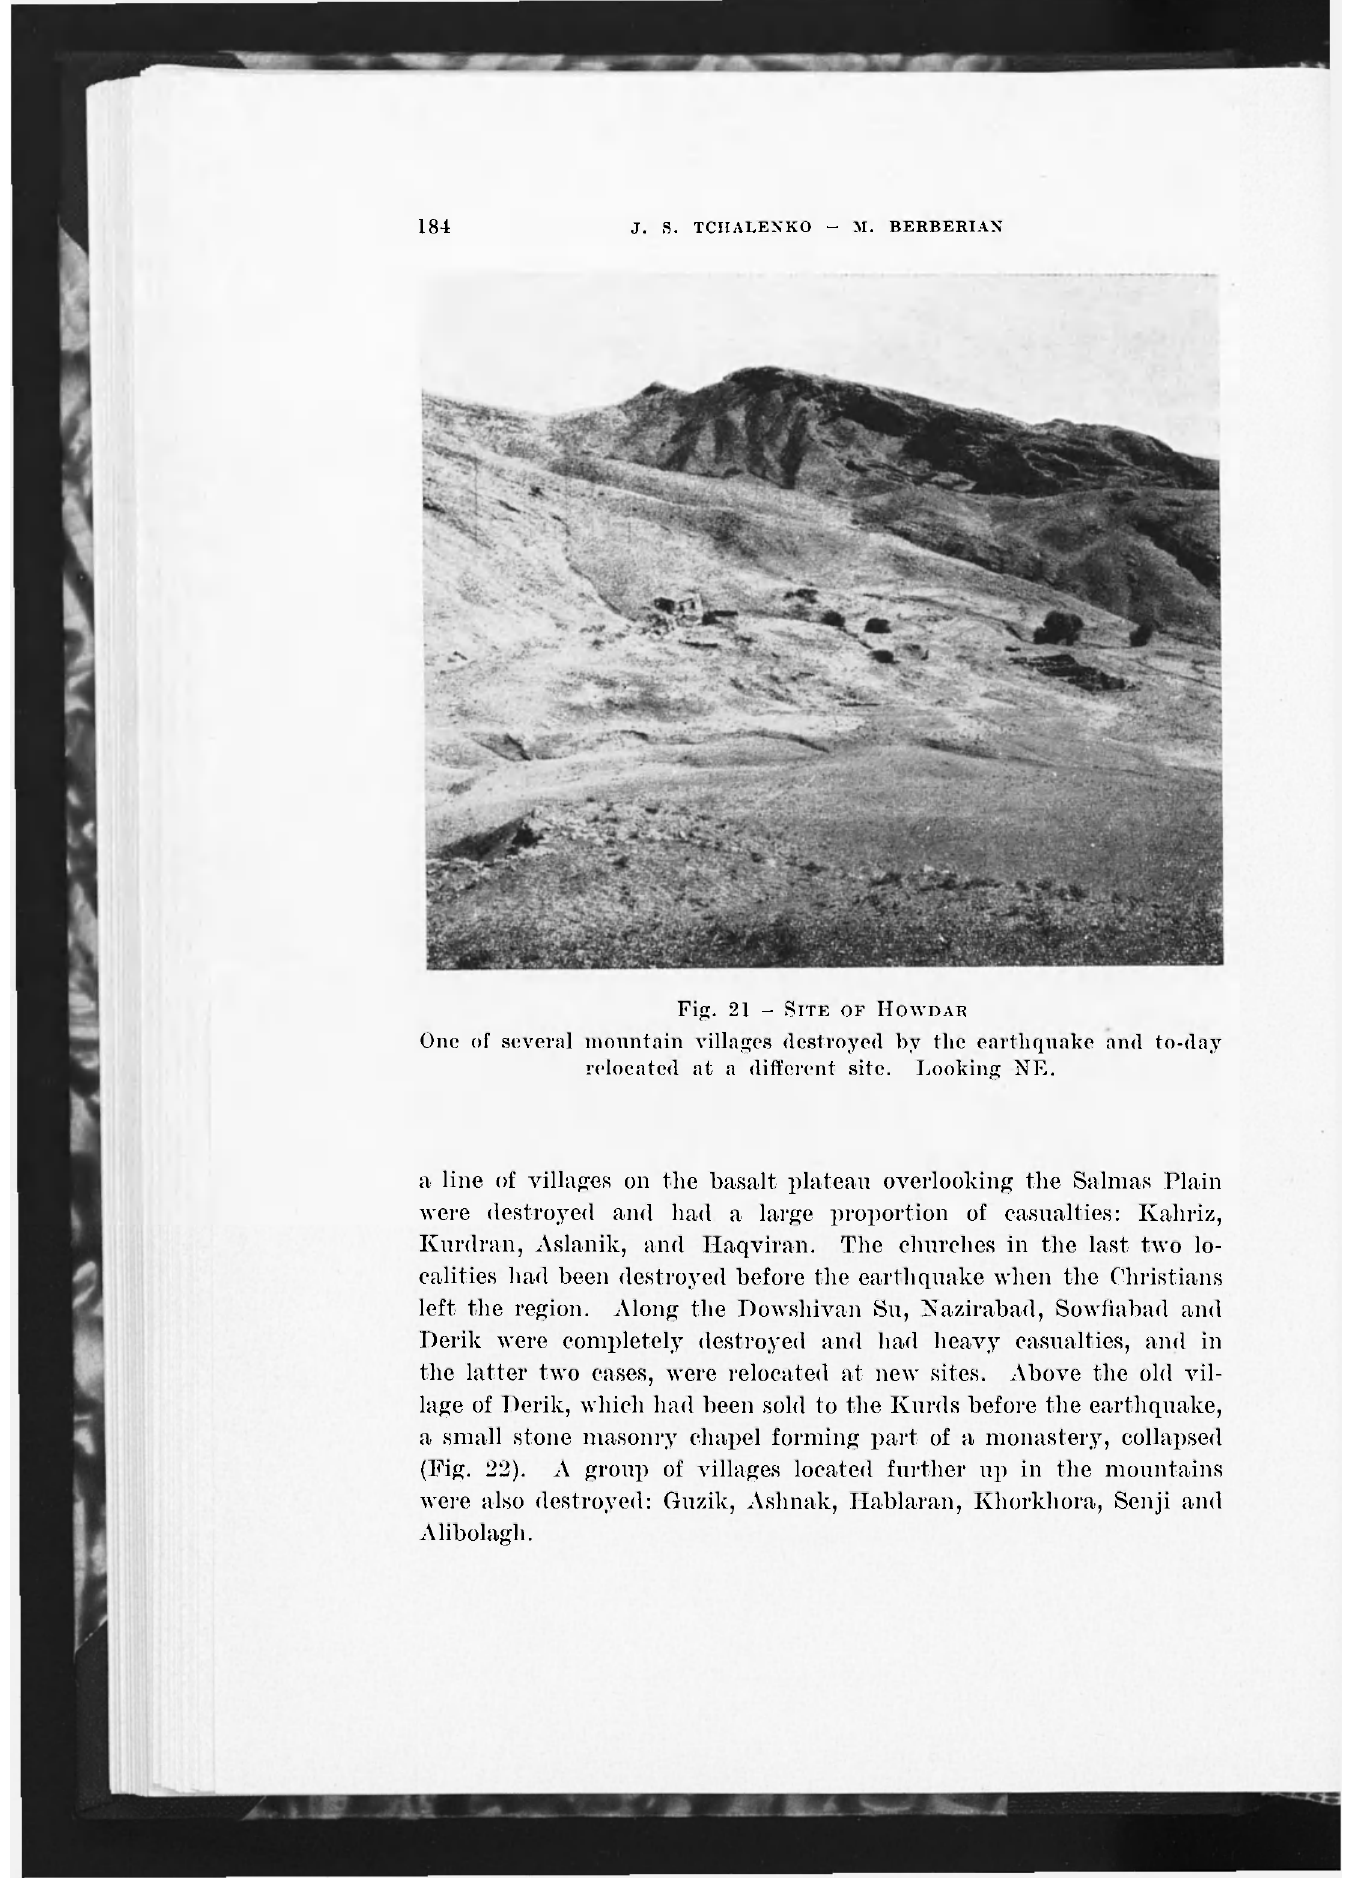
Fig. 21 - SITE OF HOWDAR One of several mountain villages destroyed by the earthquake and to-day relocated at a different site. Looking